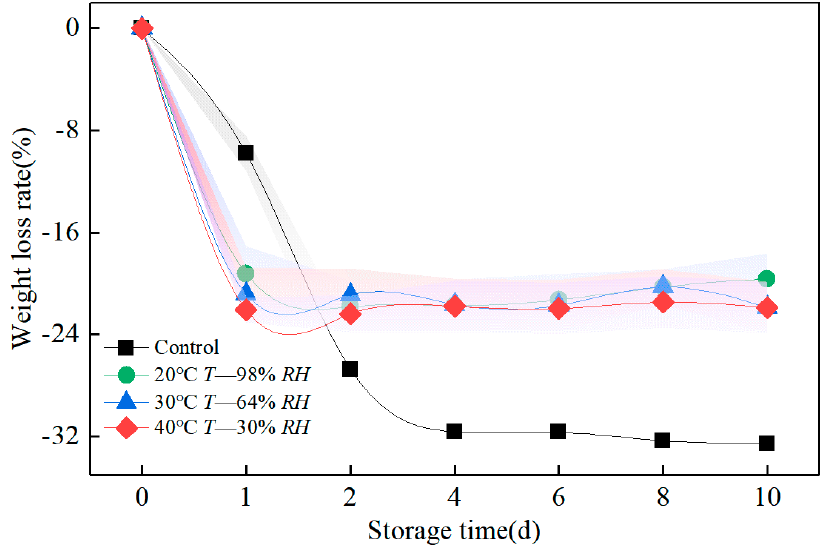
Figure 4. Effect of humidity and heat ageing on the weight of bamboo.